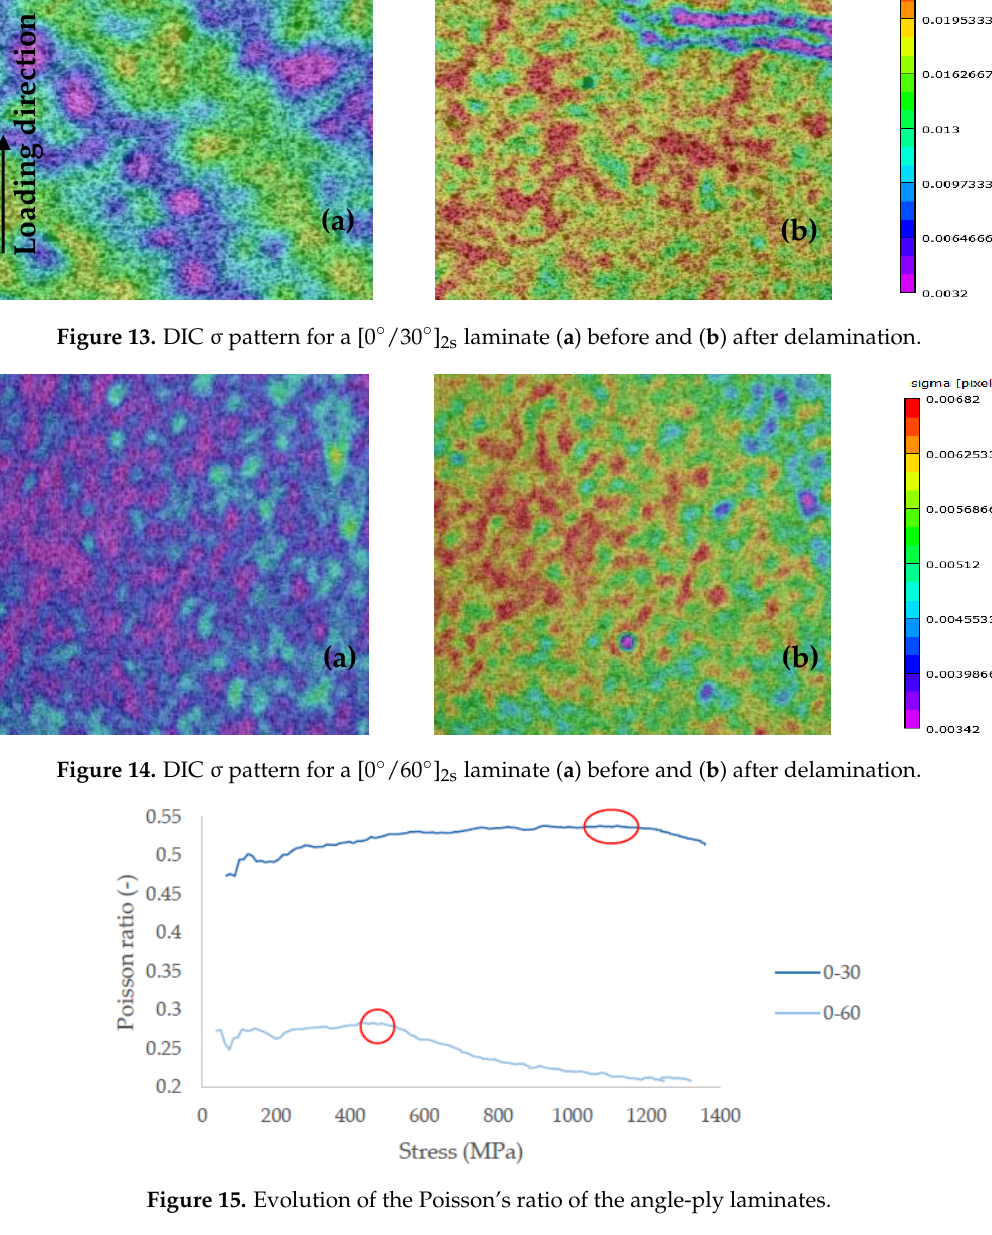
Figure 15. Evolution of the Poisson’s ratio of the angle-ply laminates.